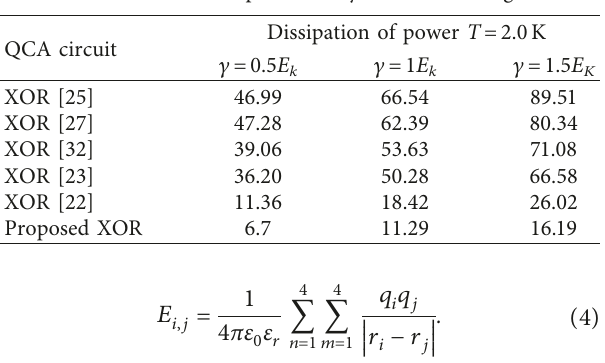
Table 3: Power dissipation analysis of the XOR